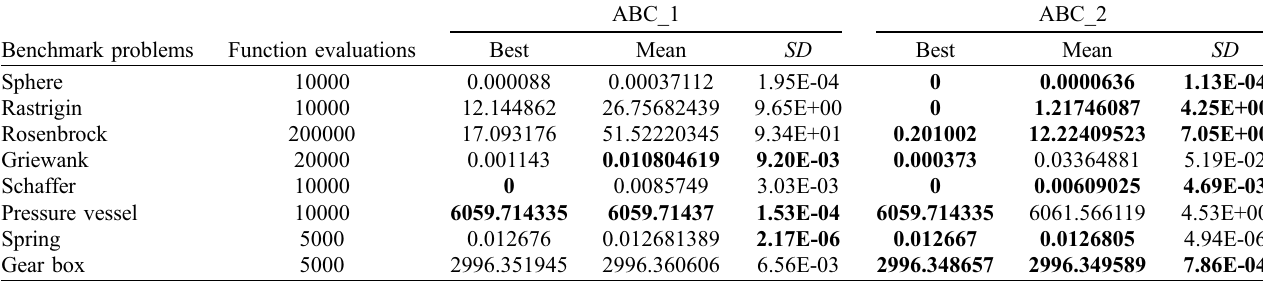
Table 1. Comparison of two different variants of ABC for different benchmark problems.